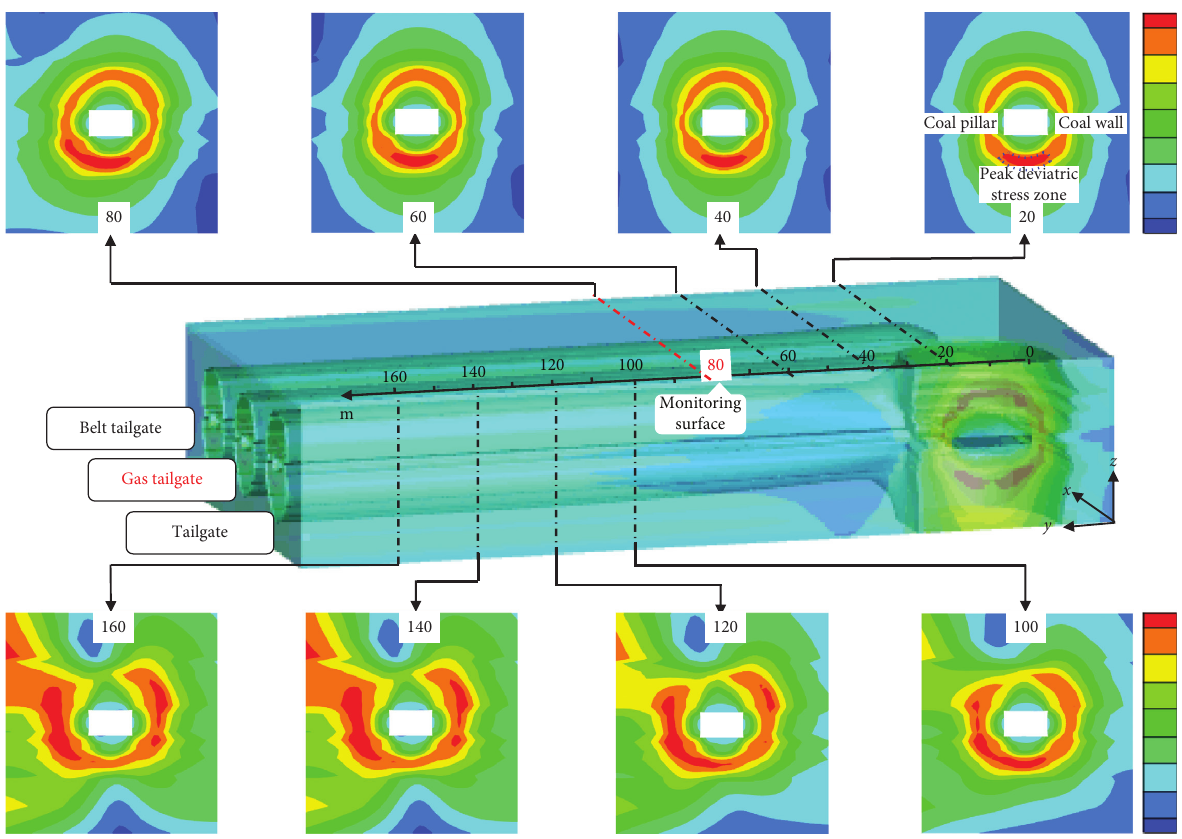
Figure 8: Deviatoric stress distribution of surrounding rock with advancement distance of the working face ( Y � 80m; unit: